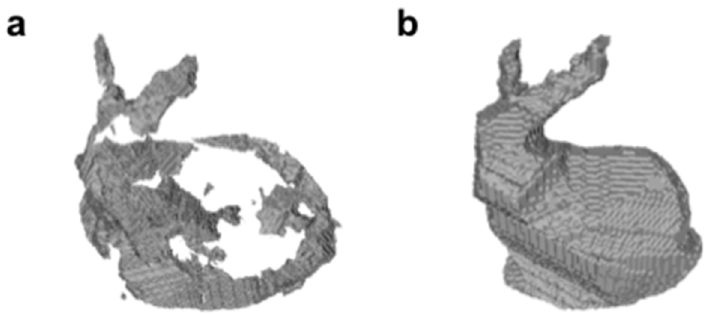
Figure 5. 3D shape reconstruction of a bunny model using ( a ) visible light and ( b ) UV transmitted light illumination.